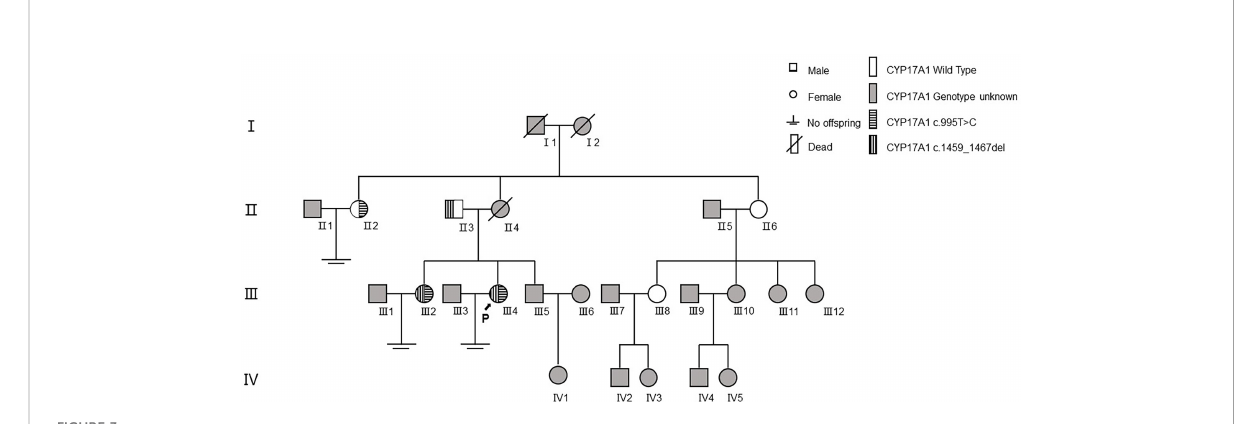
FIGURE 3 The family tree of proband